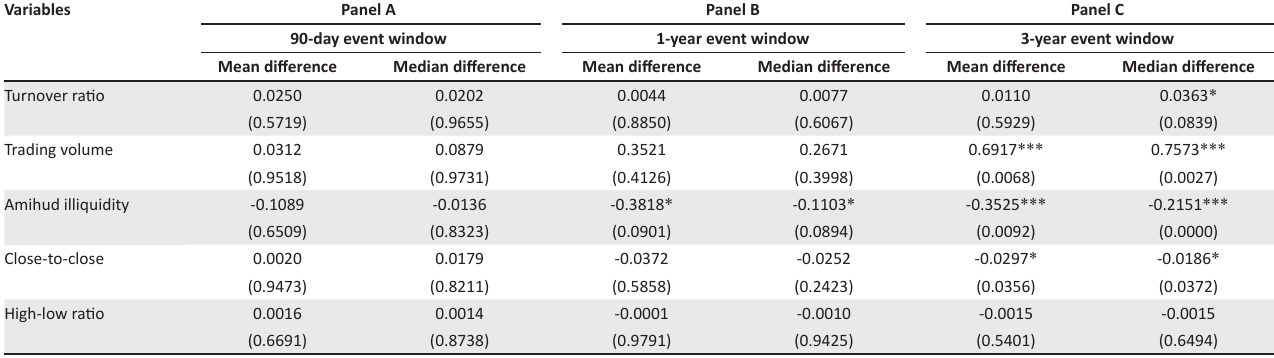
TABLE 1: Changes in liquidity and volatility around event date – Unmatched sample. Variables